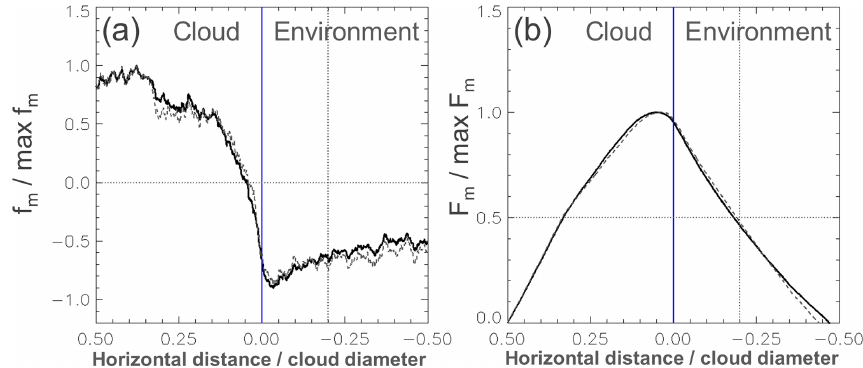
Figure 13. (a) Mean vertical mass flux ( f m ) along 191 cloud transects scaled with the maximum mass flux. The x axis is scaled with the cloud diameter. The dashed grey line shows the scaled f m for 130 along-wind transects. (b) Integrated mass flux ( F m ) from the centre of the cloud (i.e. Eq. 7) scaled with the maximum value. The dotted vertical line in both panels indicates the position of 20% of cloud diameter where ≈ 50% of the upward mass flux is compensated by the subsiding